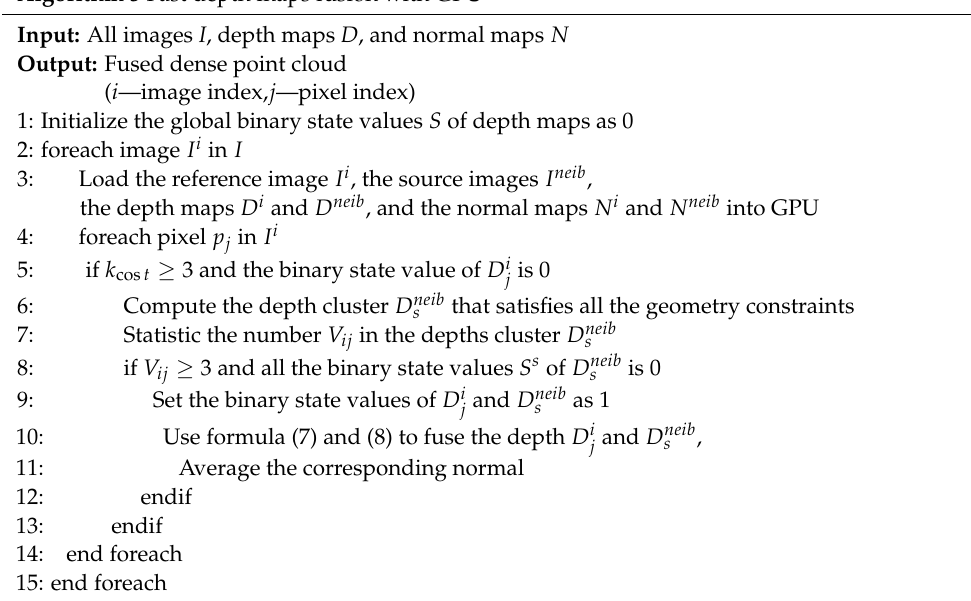
Algorithm 3 Fast depth maps fusion with